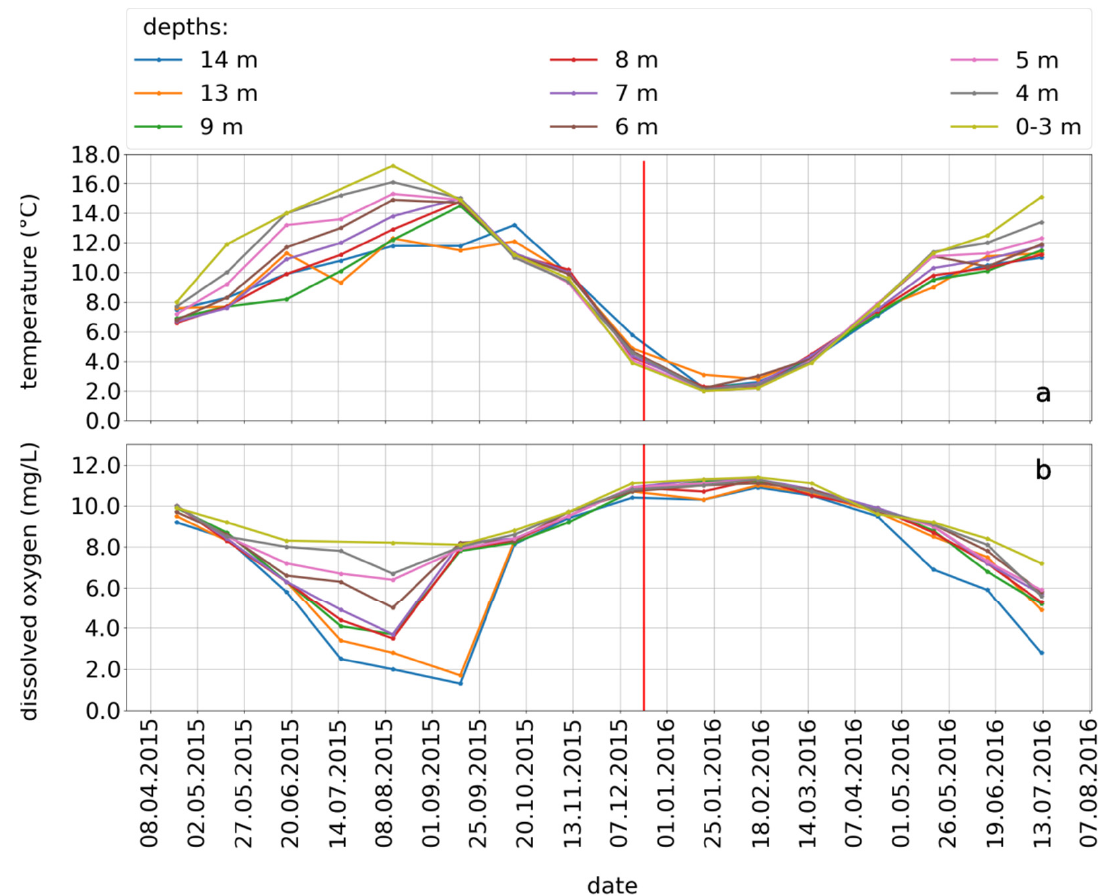
Figure 1. Distribution of the temperature ( a ) and dissolved oxygen (DO) ( b ) within the drinking-water reservoir at all different depths during the sampling time.